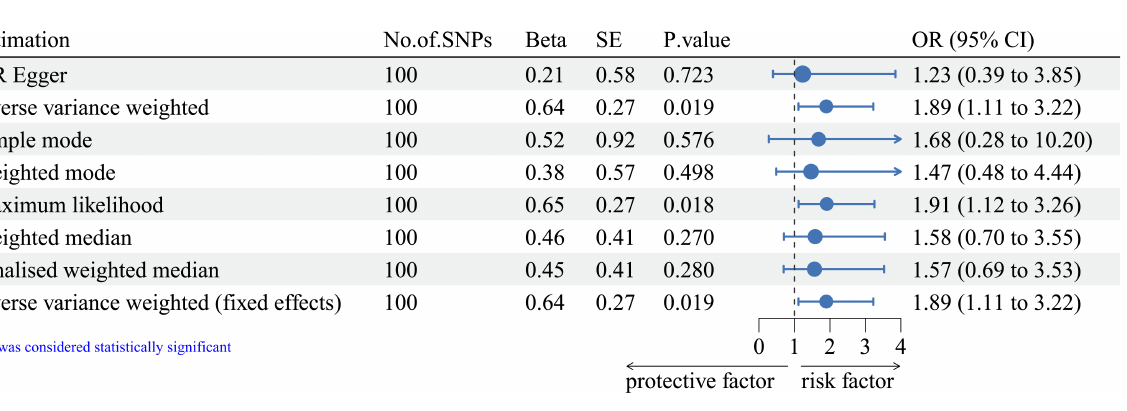
FIGURE 2 Forest plot of MR methods of the effect of telomere length on the prognosis of ER- breast cancer. MR, Mendelian randomization.